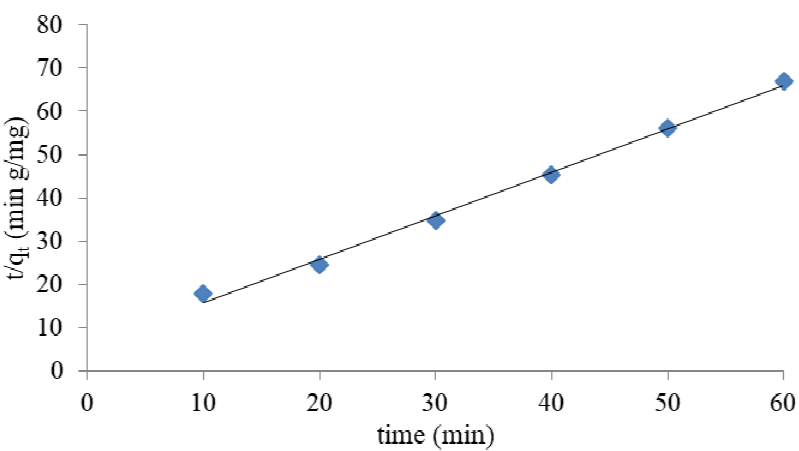
Figure 7. Second-order pseudo kinetic diagram for NH 4+ exchange.